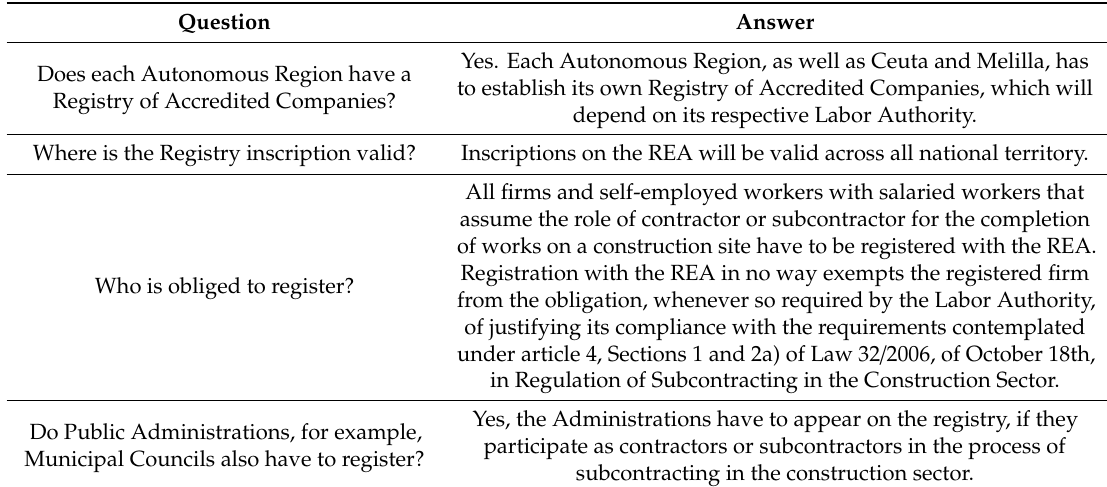
Table 2. Extract from the “Frequently Asked Questions” (FAQ) from the REA software